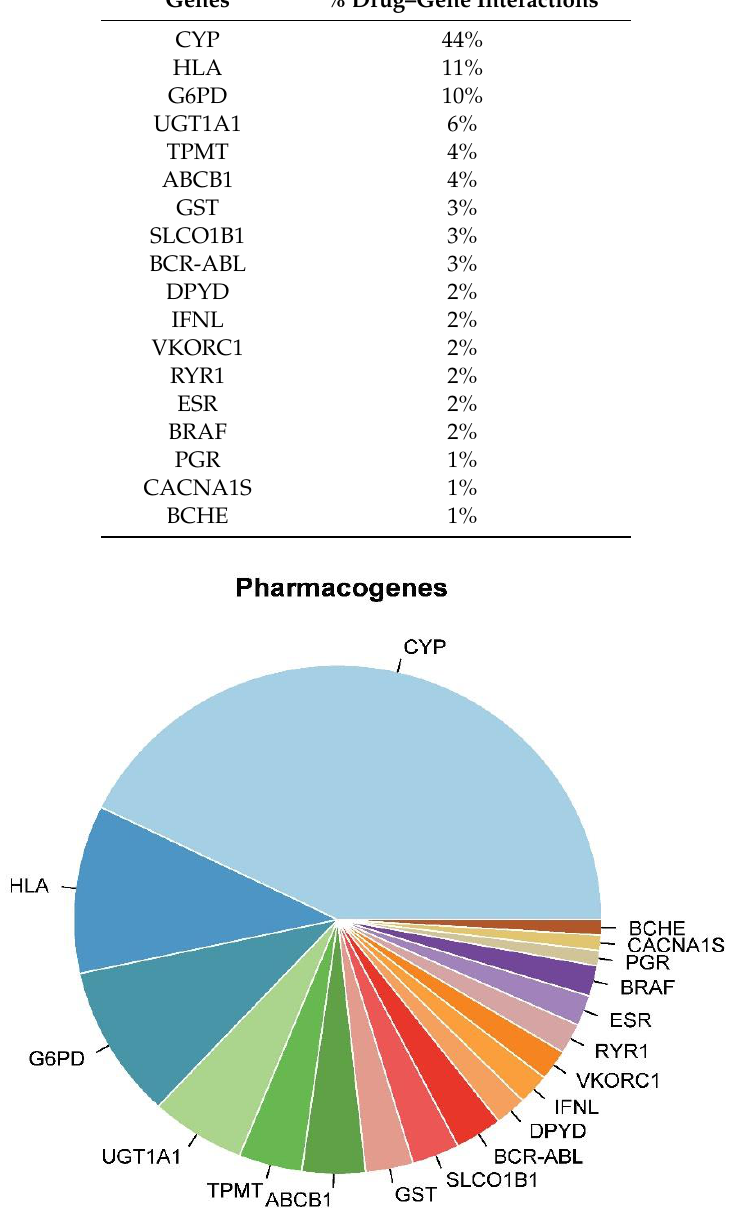
Figure 2. Pharmacogenes’ relative contributions to adverse events. CYP mutations include CYP1A2, CYP2A6, CYP2B6, CYP2CP9, CYP2C8, CYP2C19, CYP2D6, CYP2E1, CYP3A4, CYP3A5, and CYP4A11.